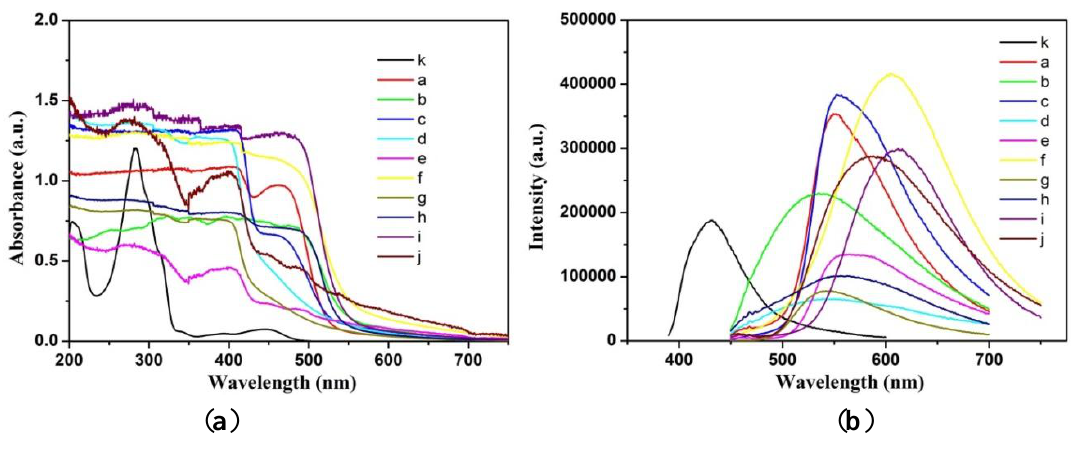
Figure 5. UV-Vis ( a ) and FL ( b ) spectra of CH-PY in xerogels ( a – j ): n-butanol, n-pentanol, isopentanol, isooctanol, cyclopentanone, cyclohexanone, nitrobenzene, n-butyl acrylate, THF, DMF, respectively, and in ethanol solution